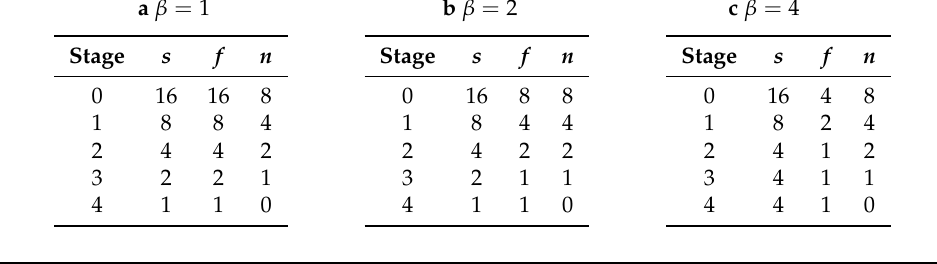
Table 3. Main parameters behaviour of the phase factor scheduling for N =